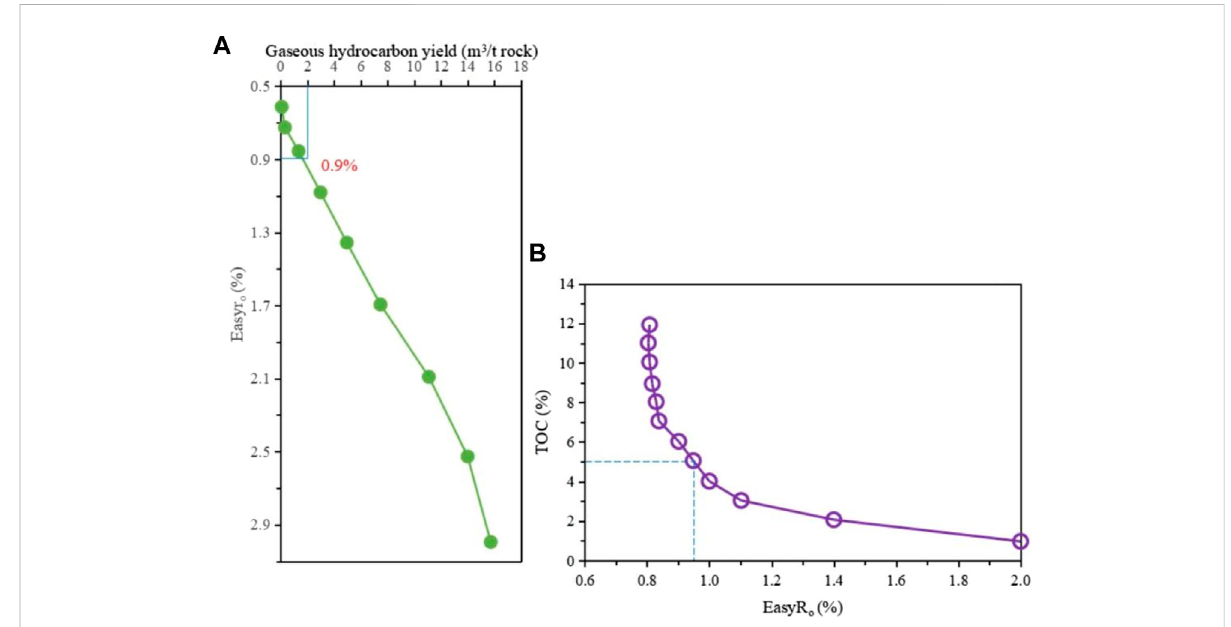
FIGURE 4 RelationshipbetweenhydrocarbongenerationpotentialparametersoftheChang7Membershale. (A) Gasgenerationpotentialperunitmassof the Chang 7 shale (based on TOC of 5%); (B) Relationship between TOC and EasyRo.